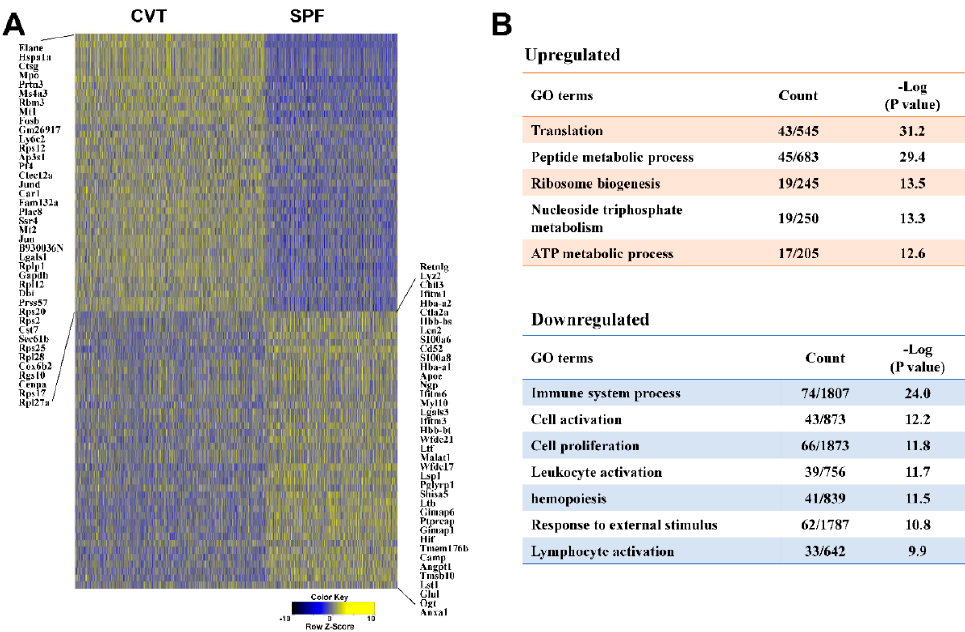
Figure A2. ( A ) Heatmap of gene expression shown distinctive patterns in KL (Lin − Kit + ) cells from CVT and SPF mice following single-cell RNA-seq. ( B ) Pathway analyses showing up- and down-regulation of genes associated with signaling pathways in CVT relative to SPF mice.